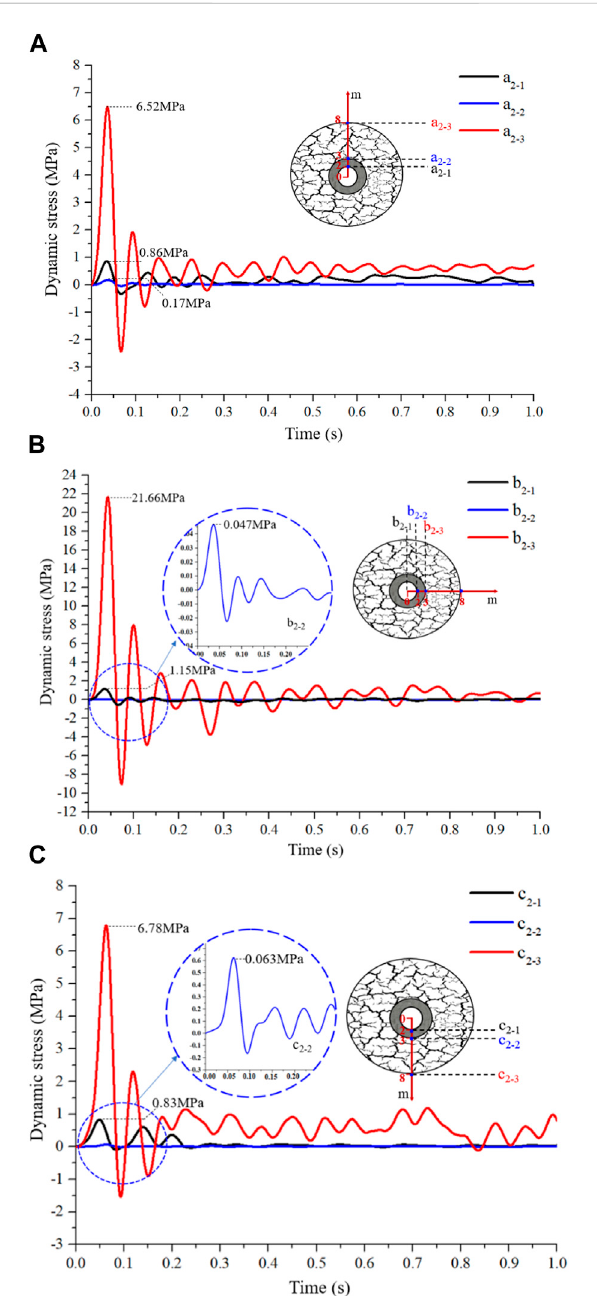
FIGURE 6 The vertical dynamic stress-time curves of monitoring points located at (A) roadway top, (B) roadway side, and (C) roadway bottom in the modi fi ed